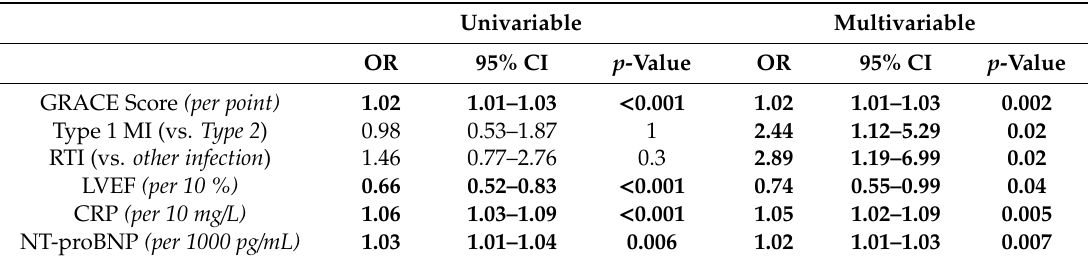
Table 4. Logistic regression analysis of factors associated with in-hospital mortality after post-infectious myocardial infarction ( n =